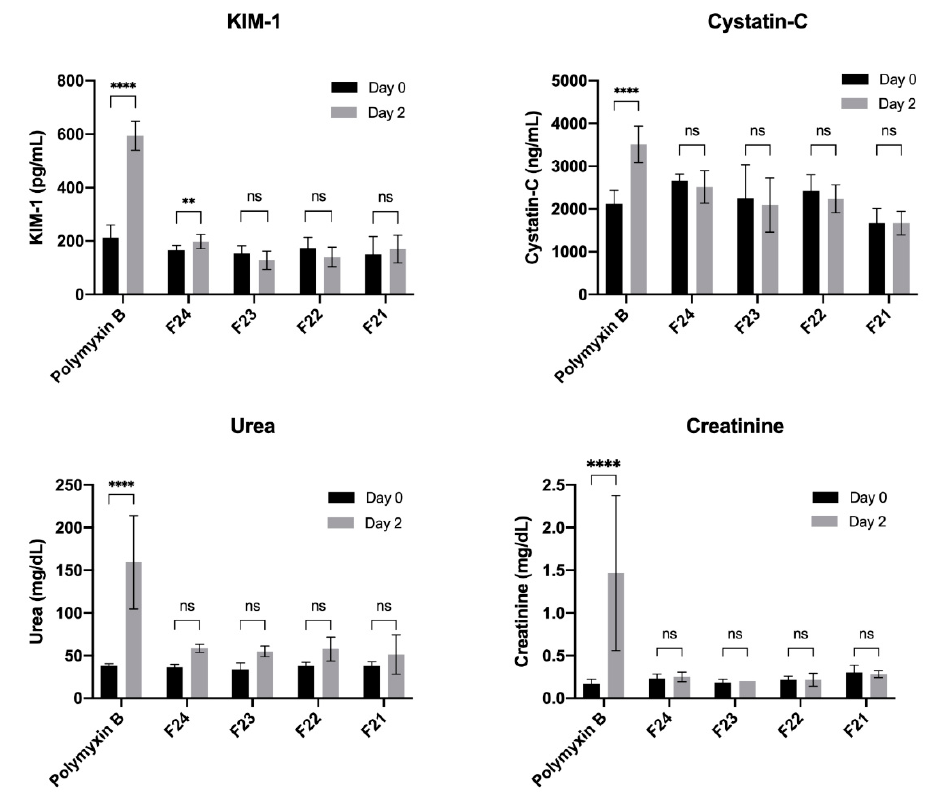
Figure 1. Biomarker response in rats before (day 0) and after treatment (day 2) with novel formulations VRP034_F21–24 and polymyxin B (control). Note: (i) In the polymyxin B (control) group, one animal died after the 7th dose and the other two died after the 8th dose. The results shown are for animals who survived treatment; n = 3. (ii) In all other treatment groups, no mortality was observed, and the results are shown for all animals; n = 6. (iii) p -values are presented for increase in biomarkers on day 2 vs. day 0; nonsignificant (ns); p < 0.01 (**); p < 0.0001 (****).